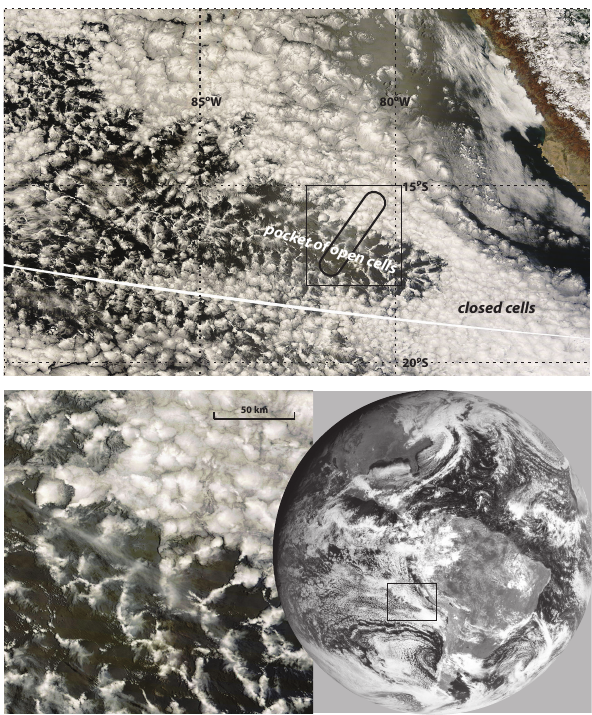
Fig. 1. Visible satellite images on 28 October 2008 showing boundary between region of closed and open cells that was sampled by the aircraft during RF06. Anticlockwise from bottom right: GOES-10 visible image from 15:00UTC; MODIS visible imagery from 15:50UTC; blow-up of MODIS visible imagery from 15:50UTC. The oval in the upper panel represents an oval containing the location of the C-130 measurements, advected using the mean MBL winds as described in the text.